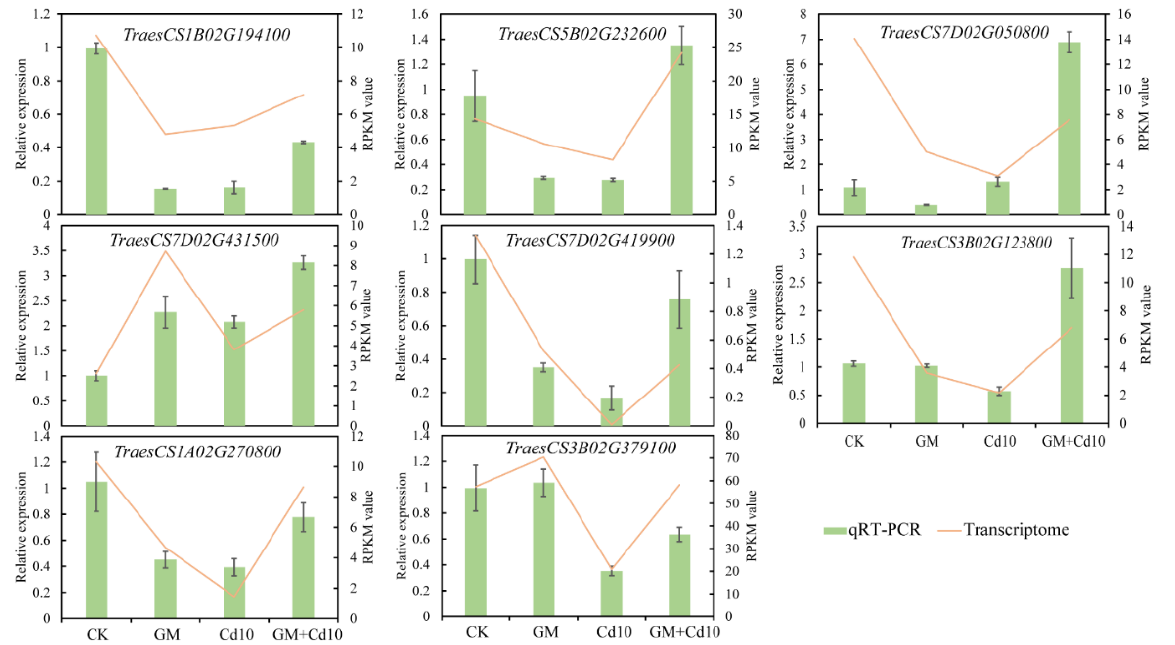
Figure 8. RT-qPCR analysis of eight representative genes in the metabolic pathways of ‘glutathione metabolism’, ‘cysteine and methionine metabolism’, ‘plant hormone signal transduction’, and ‘metal ion transport’.